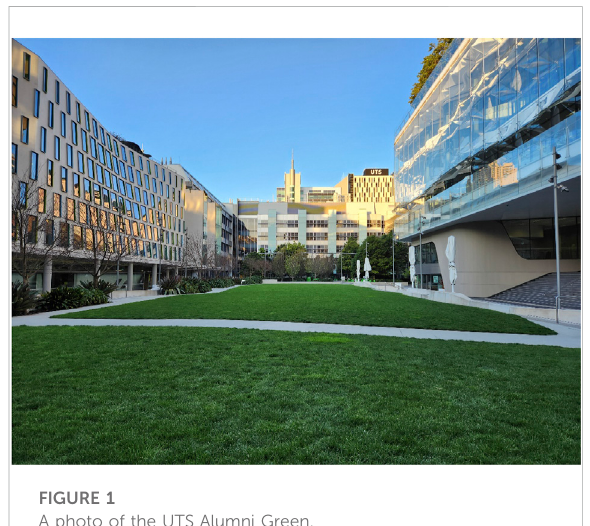
FIGURE 1 A photo of the UTS Alumni